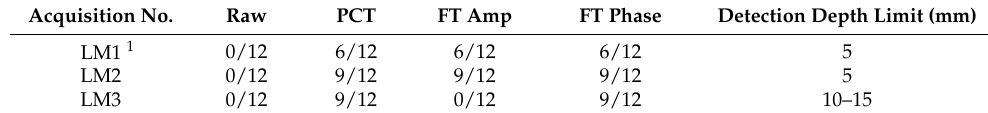
Table 10. Optical lock-in results from the inspection of the monolithic CFRP sample. Acquisition No.